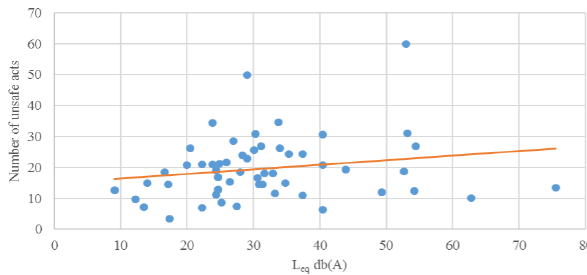
Figure 4: Relationship of L eq with the number of unsafe actions